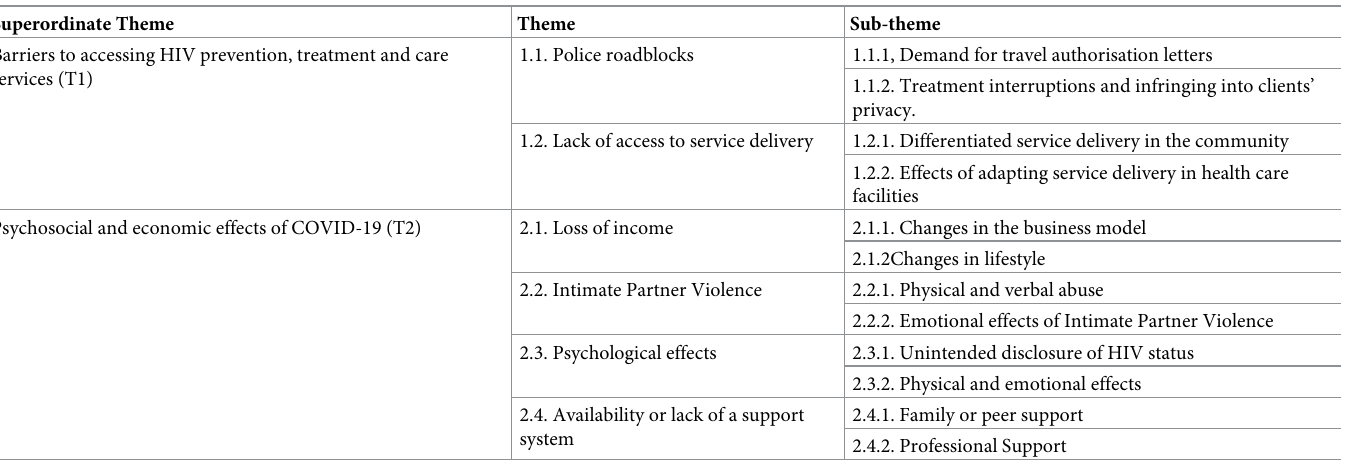
Table 2. Superordinate, theme, and sub-themes on MSM and